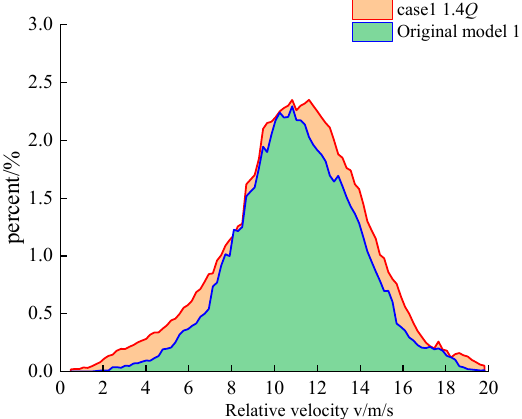
Figure 16. Velocity distribution in the impeller calculation domain at 1.4 Q.